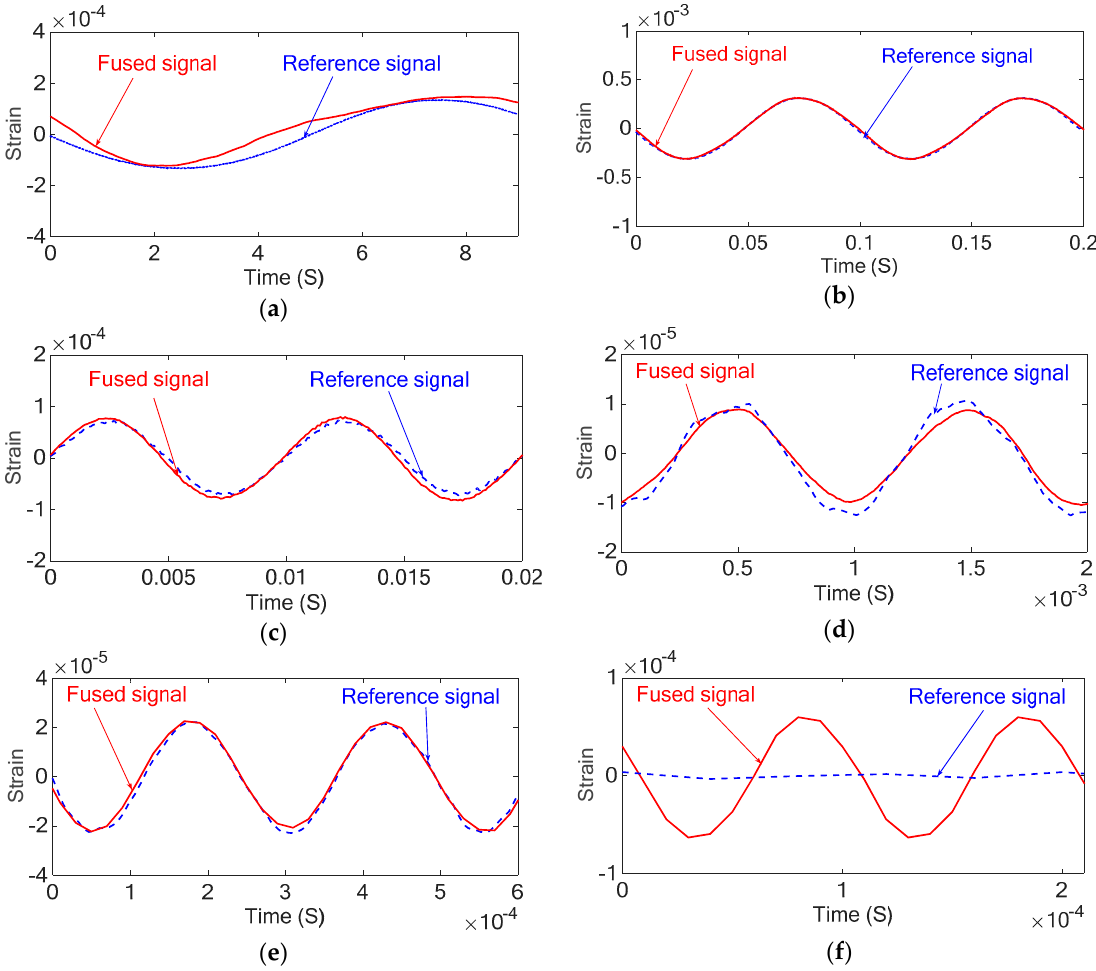
Figure 21. The fused and strain gauge signals for the strain of the cantilever under forced vibration at different excitation frequencies: ( a ) 0.1 Hz ( b ) 10 Hz ( c ) 100 Hz ( d ) 1 KHz ( e ) 4 KHz ( f ) 10 KHz.